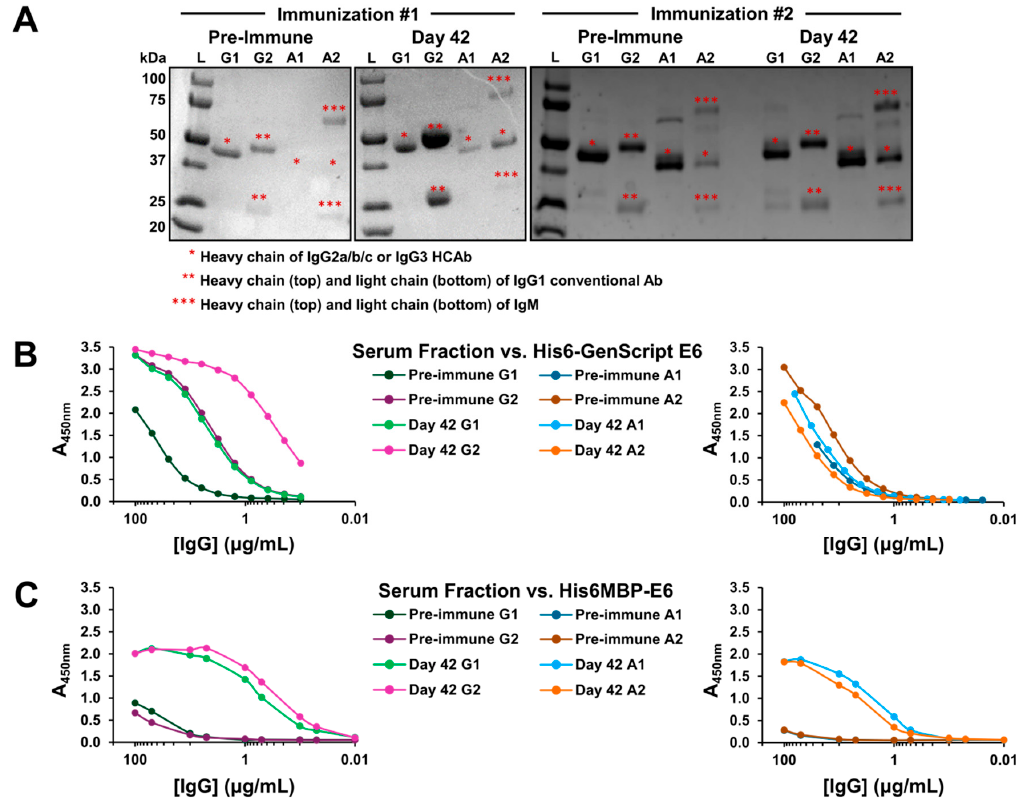
Figure 3. Serum fractionation and confirmation of a heavy-chain IgG (HCAb) immune response following each llama immunization. ( A ) Reducing sodium dodecyl sulfate-polyacrylamide gel electrophoresis (SDS-PAGE) was used to analyze the purity of the pre-immune and Day 42 serum fractions: G1 fraction = IgG3 HCAb, G2 fraction = IgG1 conventional antibody, A1 fraction = IgG2a HCAb, and A2 fraction = IgG2b / c HCAb. Approximately 2.0-2.5 µ g of sample was loaded in each lane, except for some of the more dilute A1 and A2 fractions for which smaller, but still visualizable, amounts were loaded. IgM which sometimes co-elutes with IgG2b / c was noted in all A2 fractions examined here. In the Immunization #2 pre-immune and Day 42 A1 serum fractions, an additional band is visible below the 75 kDa marker which may consist of residual unreduced HCAb. ( B ) ELISAs demonstrated that Immunization #1 Day 42 G1 and G2 serum fractions showed increased recognition for the injected recombinant antigen compared to the corresponding pre-immune serum fractions. ( C ) An increased response was also observed for all four Immunization #2 Day 42 serum